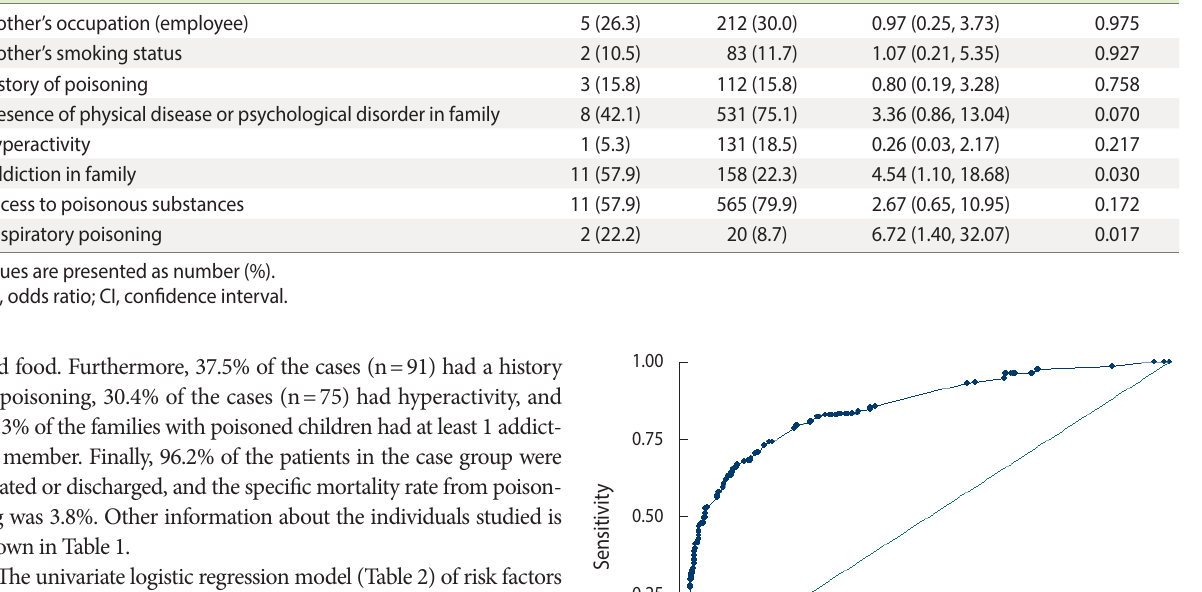
Table 3. Risk factors for mortality due to childhood poisoning by multiple logistic regression analysis Variables